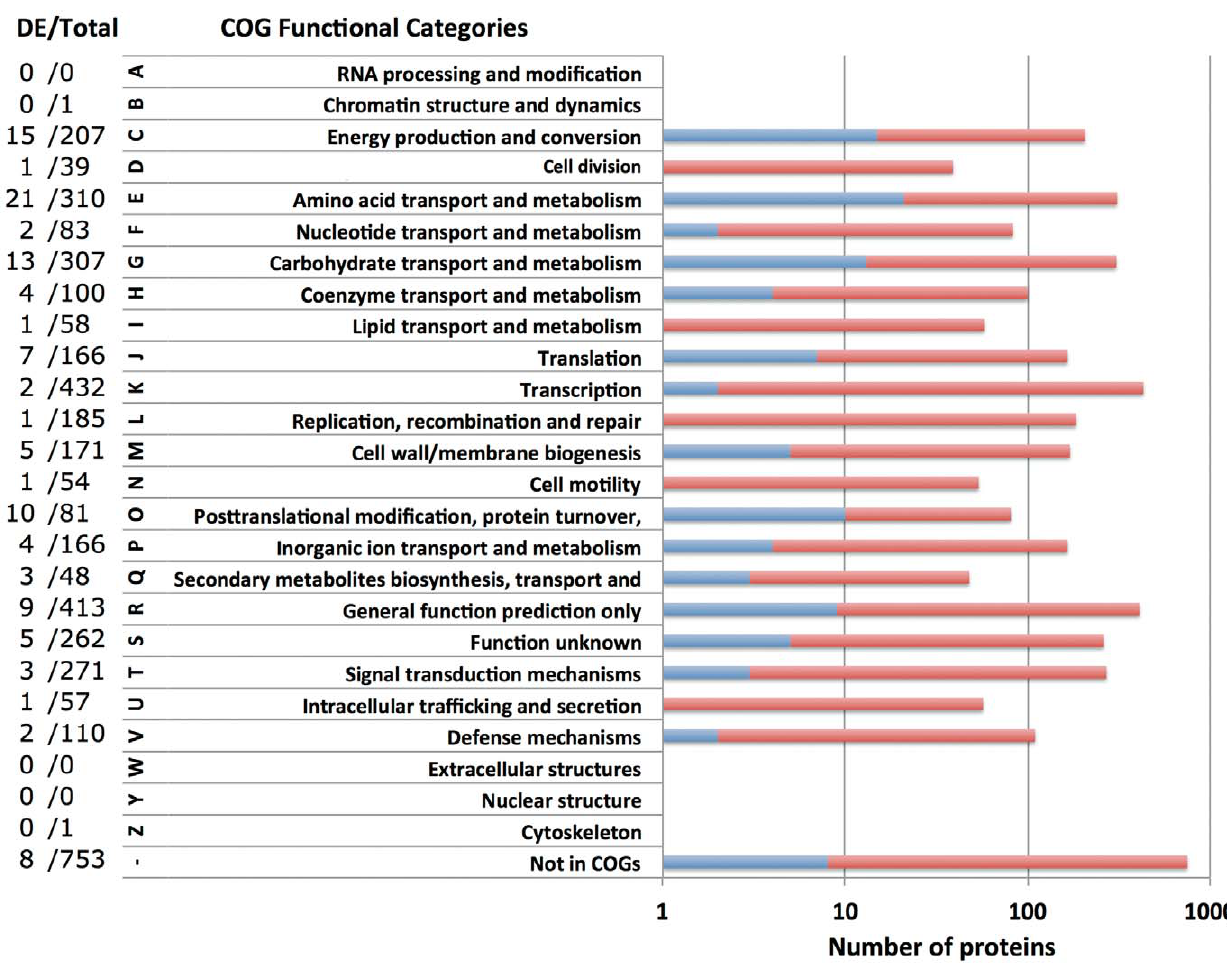
Figure 5. Distribution of differentially expressed proteins in C.difficile following invivo incubation according to COGs functional categories. Of 3,753 proteins in C. difficile strain 630, there are 3,000 proteins found in COGs database. The stacked bar chart shows the percentage of differentially expressed proteins (blue) in each COGs functional category. The number of differentially expressed proteins and the total number of proteins in each COGs are also shown on the right panel. Of 109 differentially expressed proteins, 8 are not annotated in any COGs.